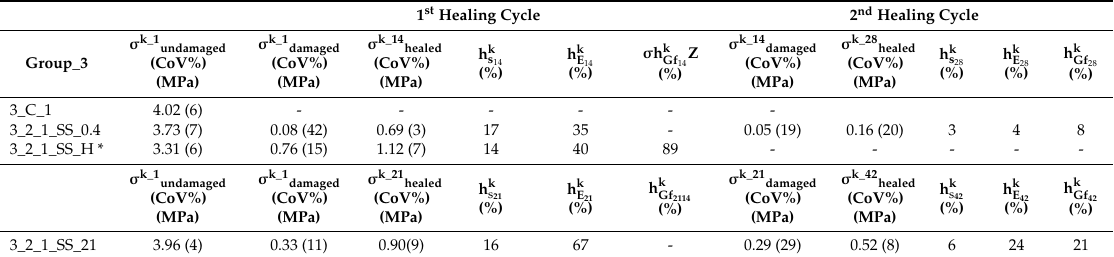
* denotes high humidity placement following initial